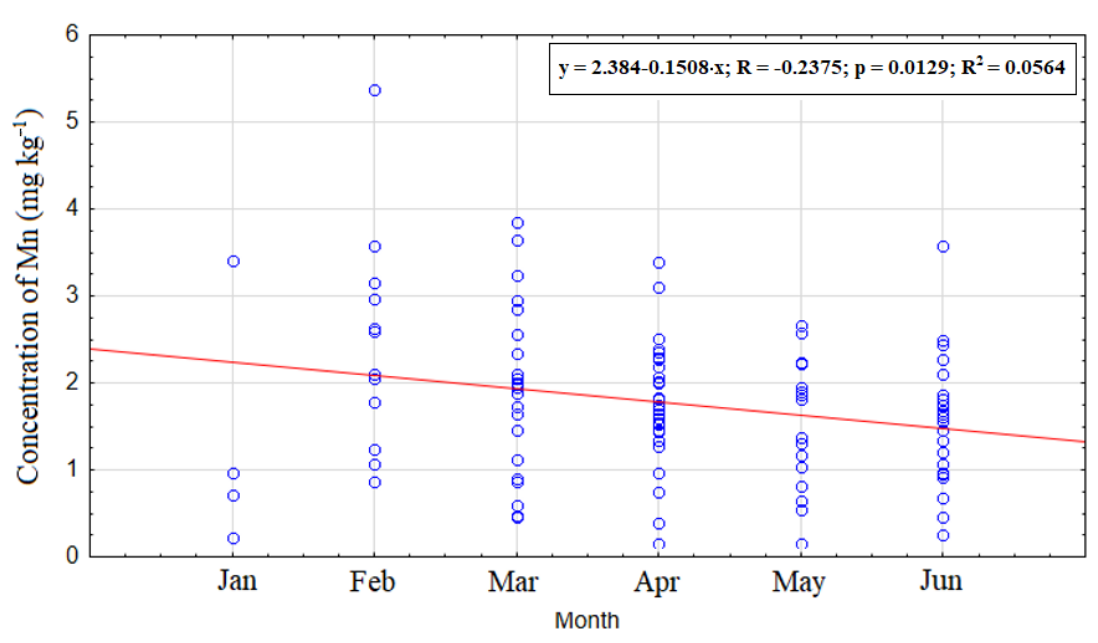
Figure 3. Temporal distribution of manganese in DSP positive mussel samples from January to June 2011.